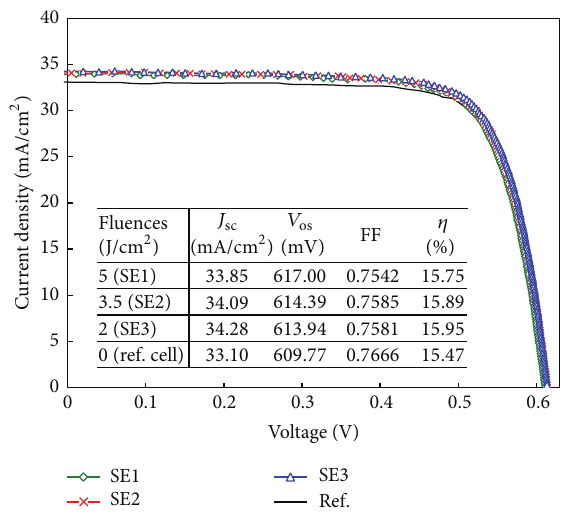
Figure 4: Comparison of current density-voltage ( J-V ) curves of SE mc-Si solar cells with different laser fluences (5, 3.5, 2, and 0J/cm 2 for SE1, SE2, SE3, and Ref. cell, resp.) under standard measuring conditions (AM 1.5 spectra, 1000Wm −2 , 25 ∘ C). Performances of the developed cells are also included in bottom insert.